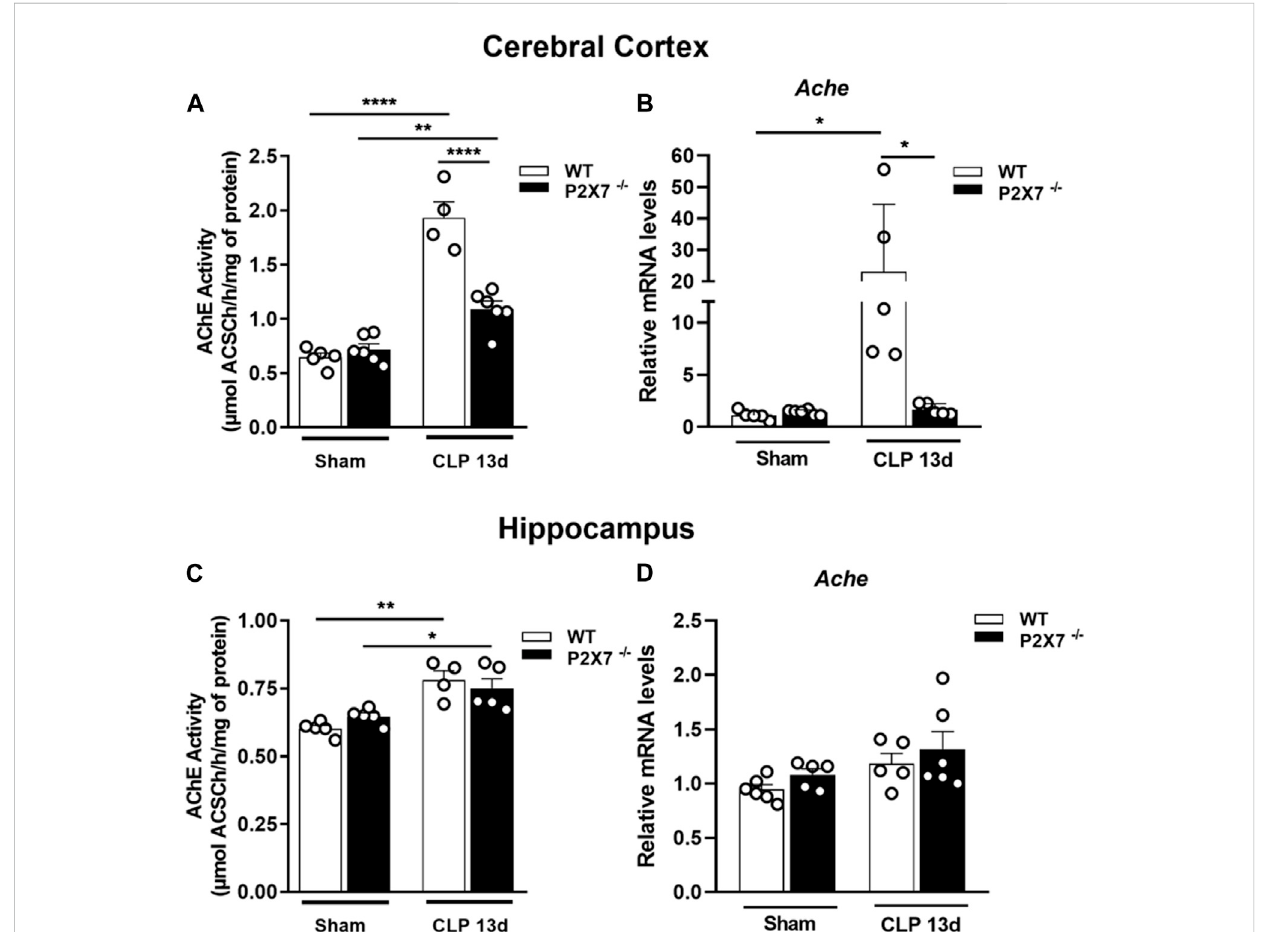
FIGURE 2 P2X7 receptor functionality increases acetylcholinesterase activity in the cerebral cortex and hippocampus of sepsis-surviving mice. Acetylcholinesterase activity was analyzed by a colorimetric and enzymatic assay and gene expression by RT-qPCR. AChE activity in the cerebral cortex (A) and hippocampus (B) of CLP and sham mice. Gene expression in the cerebral cortex (C) and hippocampus (D) Data are expressed as mean ± SEM; One-way ANOVA followed by Tukey ’ s post hoc . Asterisks represent statistical differences between groups (* p < 0.05; ** p < 0.001; **** p < 0.0001). Symbols represent individual mice. ( n = 4 –